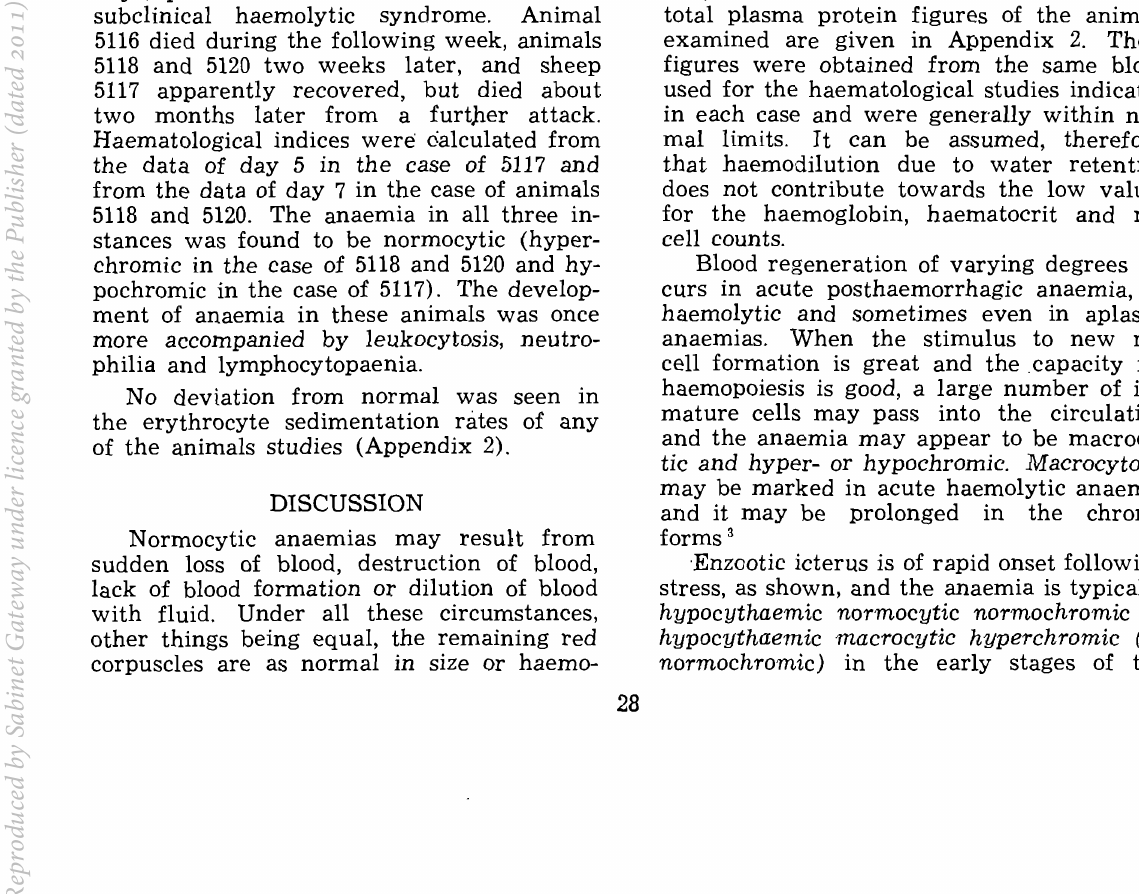
N.B.: The abbreviatiolls in this table are as given at the foot of Table I. fects of the combined stress (duration 6-7 days) provoked a severe exacerbation of the subclinical haemolytic